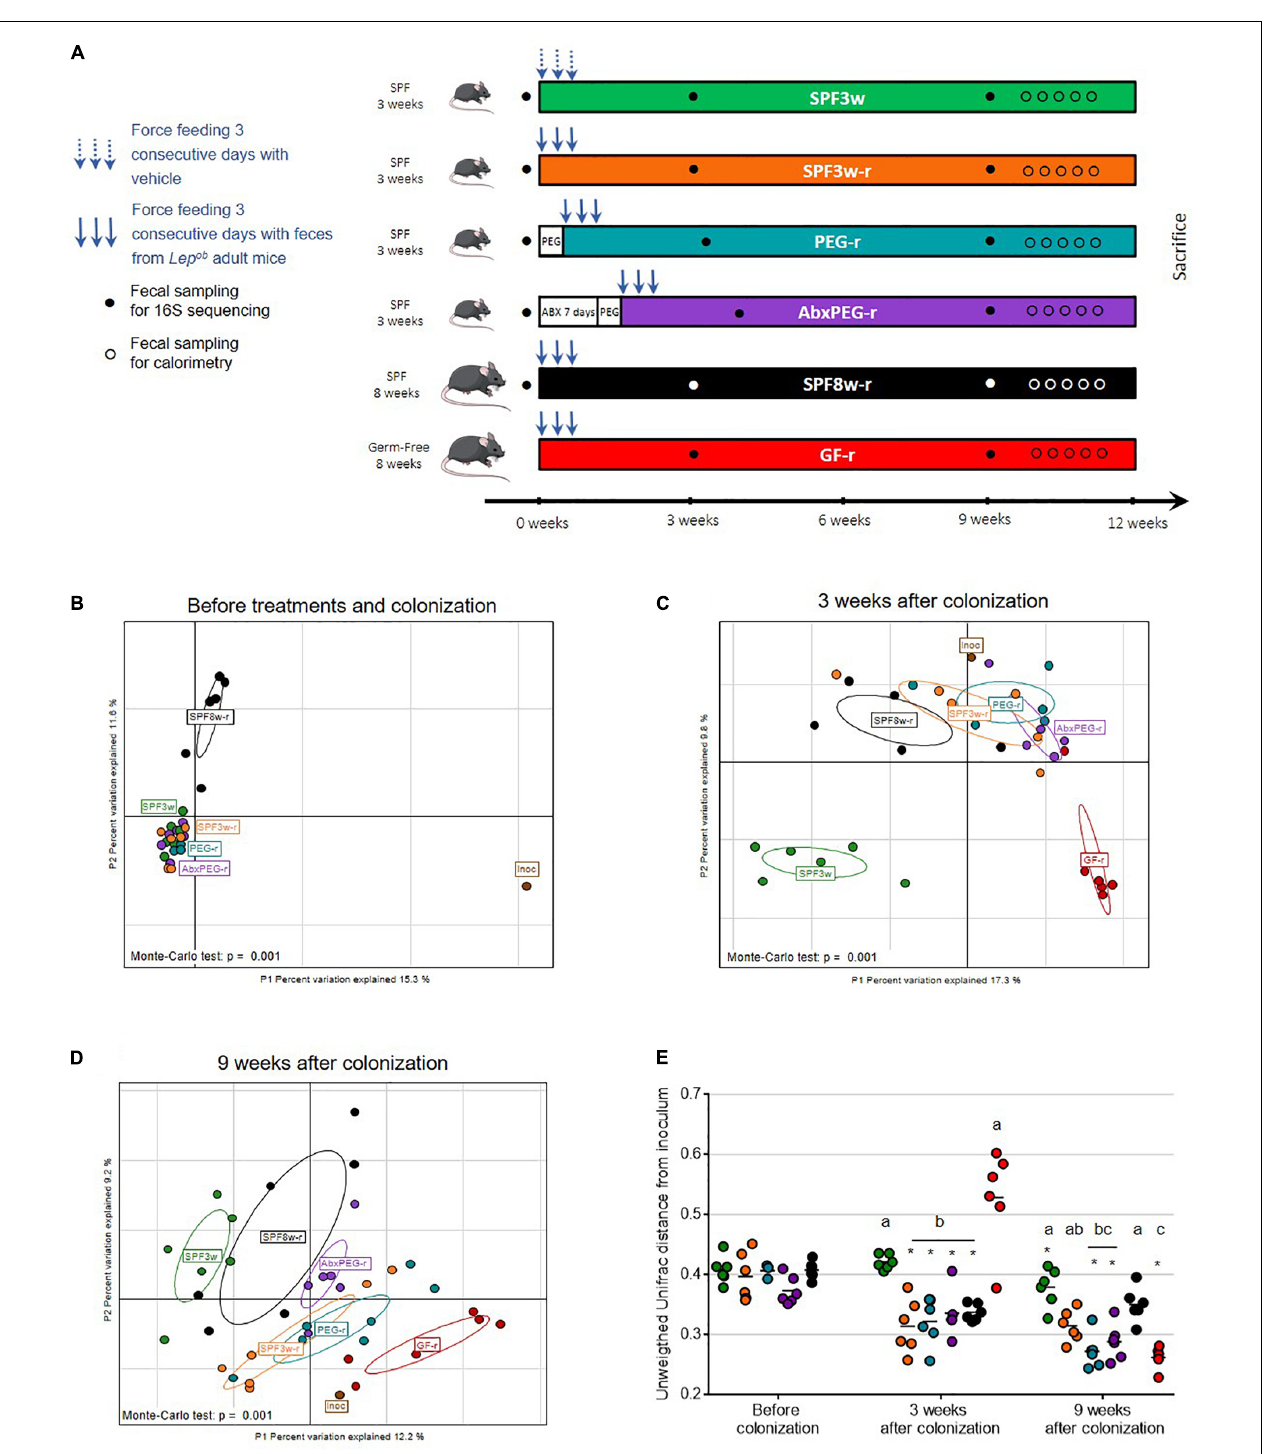
FIGURE 1 | Impact of recipient age, microbiological status, and pre-treatment on fecal microbiota transfer. (A) Experimental design. (B–D) Interclass principal component analysis performed based on OTUs (operational taxonomic units) abundance before (B) , three weeks (C) , and 9 weeks after fecal microbiota transfer (D). Mice microbiota compositions were clustered and the center of gravity computed for each group. The p -value of the link between recipients’ groups and OTUs abundance was calculated using a Monte Carlo test (999 replicates). (E) Unweighted Unifrac distance between the inoculum and recipients bacterial communities. For all figures: Inoc, inoculum; SPF, Specific pathogen free; GF, Germ-free; PEG, polyethylene glycol; Abx, antibiotics; 3w, 3-week old; 8w, 8-week old; r, recipient. Groups with differing letters are significantly different (adjusted p < 0.05). ∗ At a time-point indicates a significant change since the previous time-point.